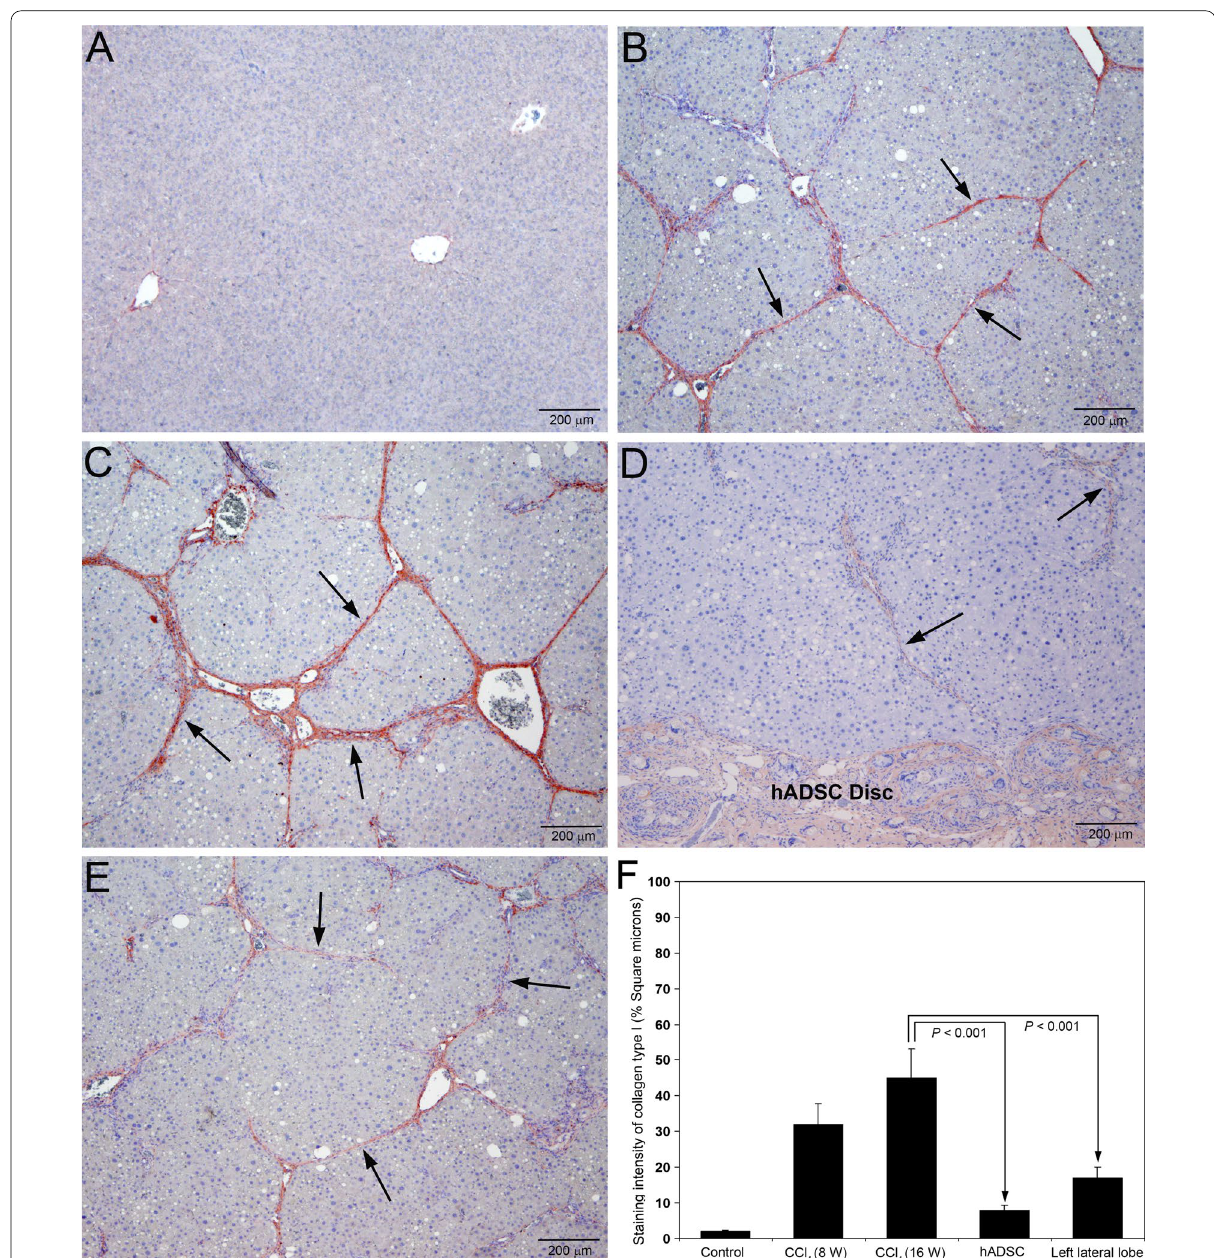
Fig. 7 Immunohistochemical staining for collagen type I in rat liver sections following serial administrations of CCl 4 and after treatment with hADSC disc. A Staining for collagen type I was absent in the hepatic parenchyma of control livers treated with olive oil for 16 weeks. B At 8th week of CCl 4 administration, there was marked staining for collagen type I in the fibrotic zone indicating deposition of newly formed collagen (arrows). C At 16th week, the staining for collagen type I became more prominent depicting thick collagen fibers (arrows). D Treatment with hADSC disc for 8 weeks resulted in marked decrease of collagen type I staining indicating decreased synthesis and deposition of collagen type I (arrows). The hADSC disc with weak staining for collagen type I is visible at the bottom portion. E Marked reduction of staining for collagen type I in the left lateral lobe, where the right lateral lobe is implanted with hADSC disc. The collagen type I fibers were thin with incomplete fibrous septa and partial bridging (arrows). Original magnification, 40. F The staining intensity of collagen type I was quantified using Image-Pro Discovery software. The data are × mean S.D. of 10 randomly selected microscopic fields from five rats per ±